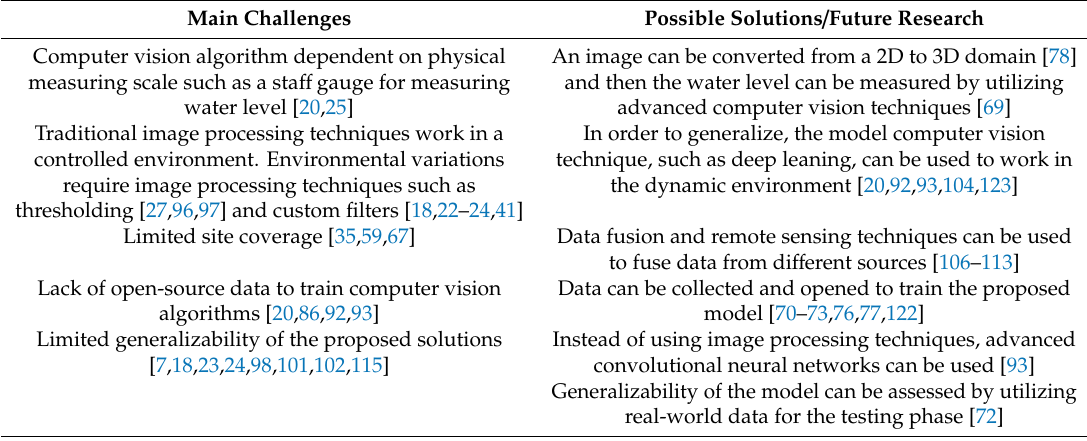
Table 10. Main challenges addressed against possible solutions and future